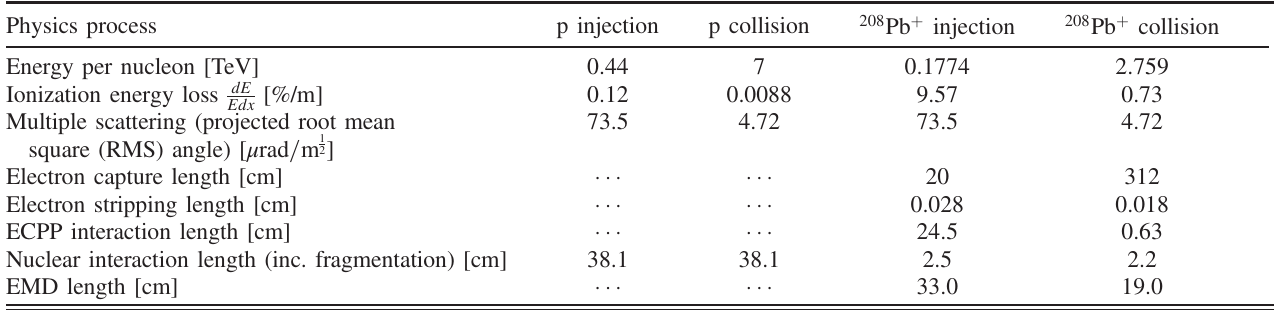
TABLE II. 208 Pb þ ion-matter interactions in comparison with proton-matter interactions. ECPP and EMD stand for electron capture pair production and electromagnetic dissociation respectively. Values are for particle impact on graphite [1]. Physics process p injection p